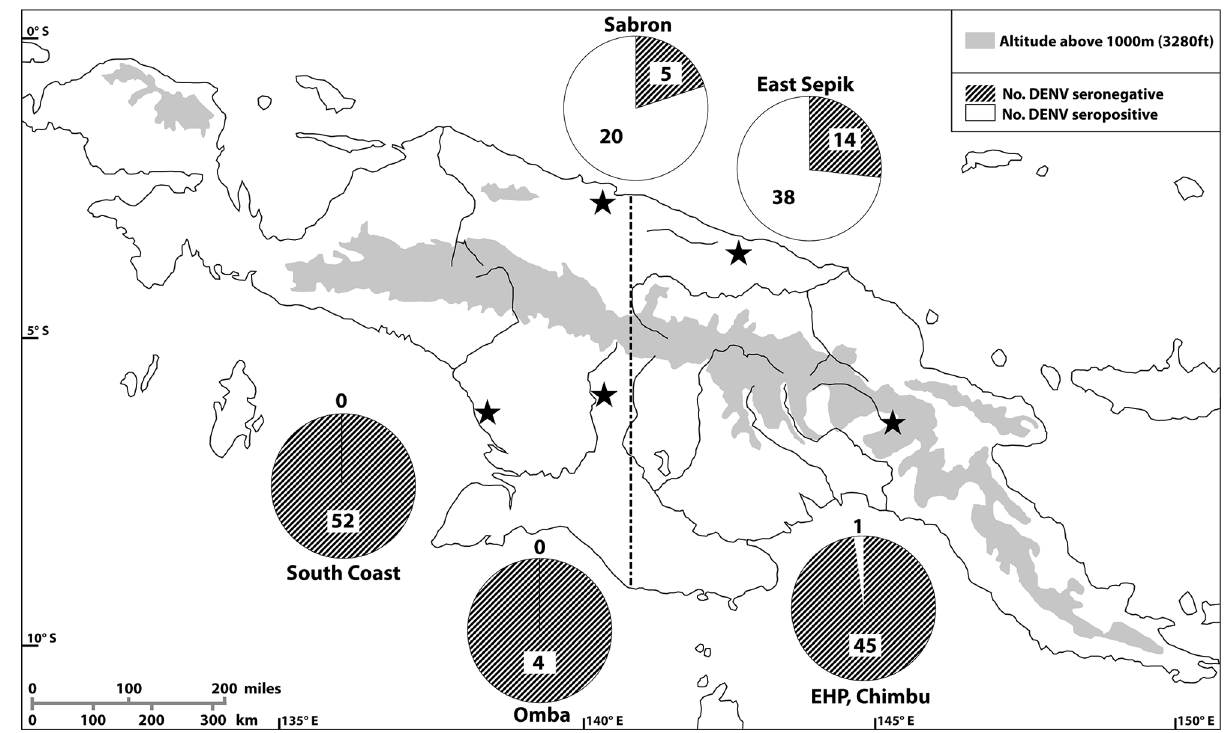
Fig 1. DENV seroprevalence, Papua New Guinea and West Papua 1959–1963. Previous DENV infectionwas largely identifiedin Sabron and East Sepik on the northerncoast, with a single case in the Eastern Highlands. All sera from the southerncoast were seronegative. Stars indicateorigin of serum samples collectedbetween1959–1963. Circles depict numberof sera collectedat each site, and proportionof sera anti-DENVseropositive and anti-DENVseronegative. Dashedline represents border betweenNew Guinea (now known as Papua New Guinea)to the east, and Dutch New Guinea (now known as West Papua) to the